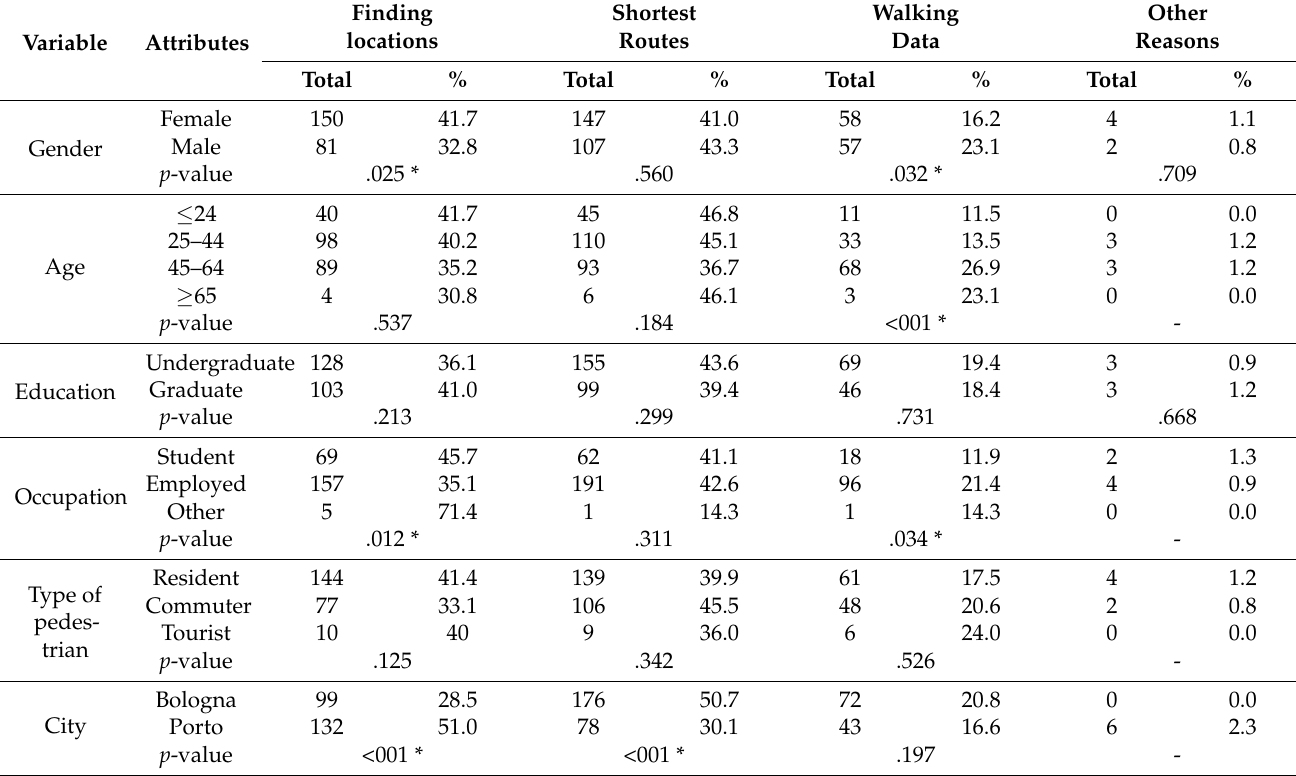
Table 3. Reasons for using a pedestrian navigation app ( N =